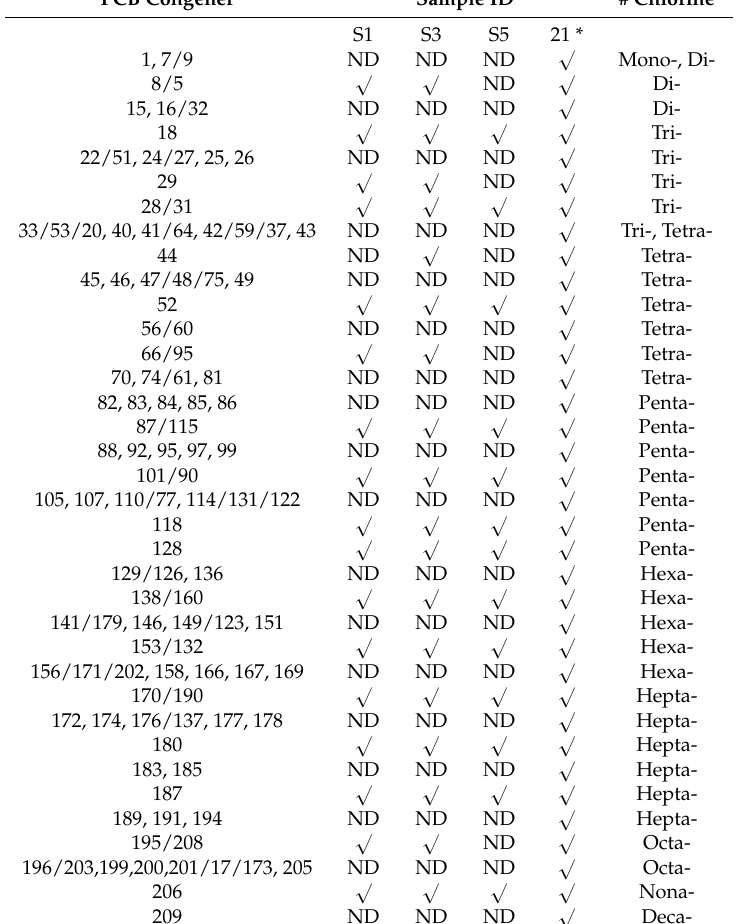
Table 2. Presence of PCB congeners in submerged sediment samples (S1 and S3) and the intertidal sediment samples (S5). PCB103 and PCB198 are not shown as they were used as internal